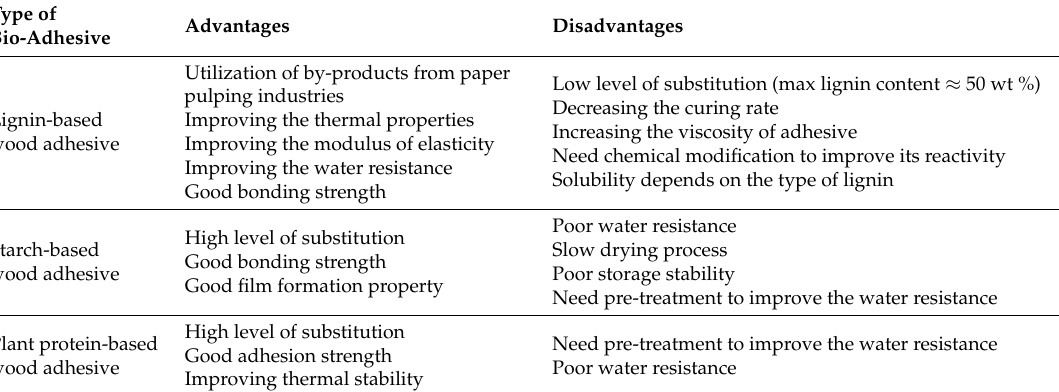
Table 1. Advantages and disadvantages of bio (lignin, starch and plant protein)-based wood adhesives. Type of